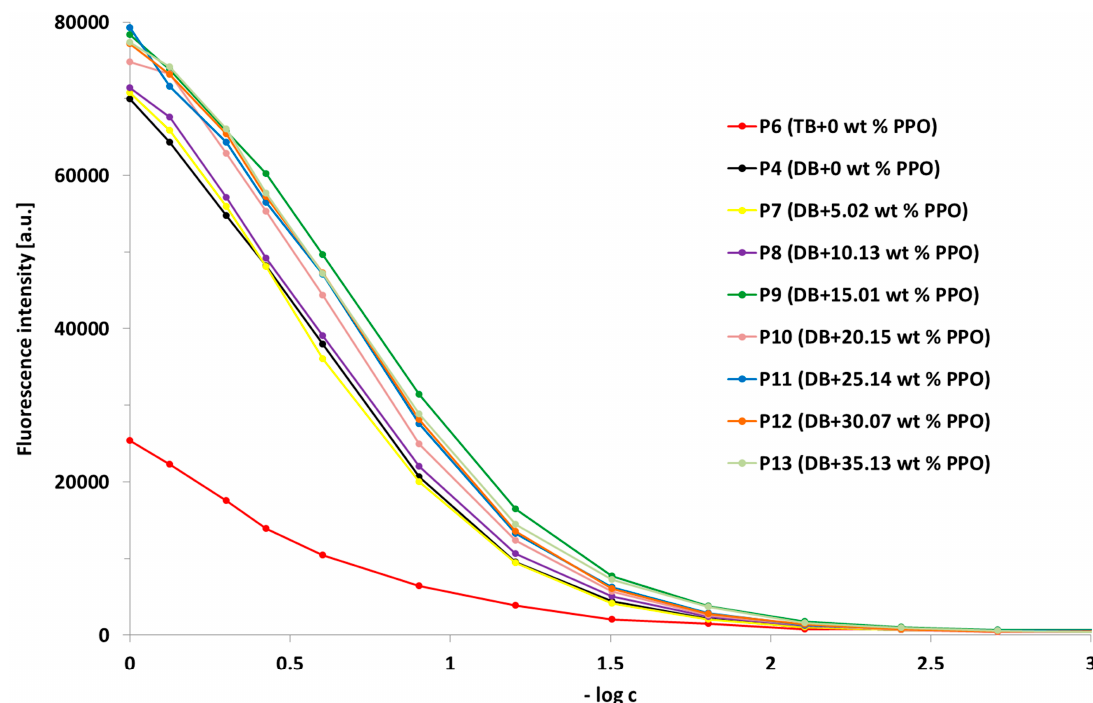
Figure 4. Dependence of fluorescent intensity on the concentration of the triblock and diblock micelles; fluorescent intensity of fluorescent dye Nile Red of diblock copolymers determined after 30 min at λ ex / λ em = 530/610 nm in PBS buffer at 37 °C. The CMC was determined as the intersection of two straight lines drawn through points at low and high concentration from the graph of dependence of fluorescence intensity on negative logarithm of sample concentration.